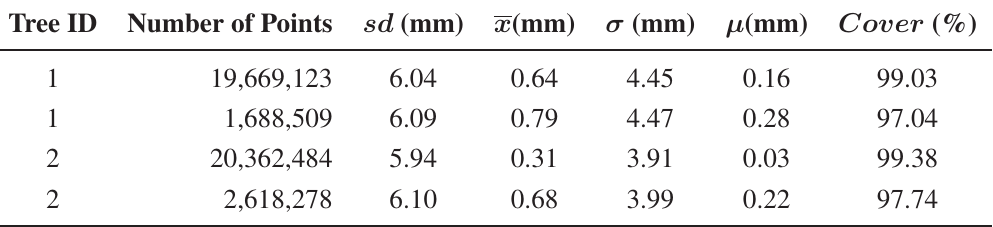
Table 4. The impact of lowering the point cloud density on the goodness of